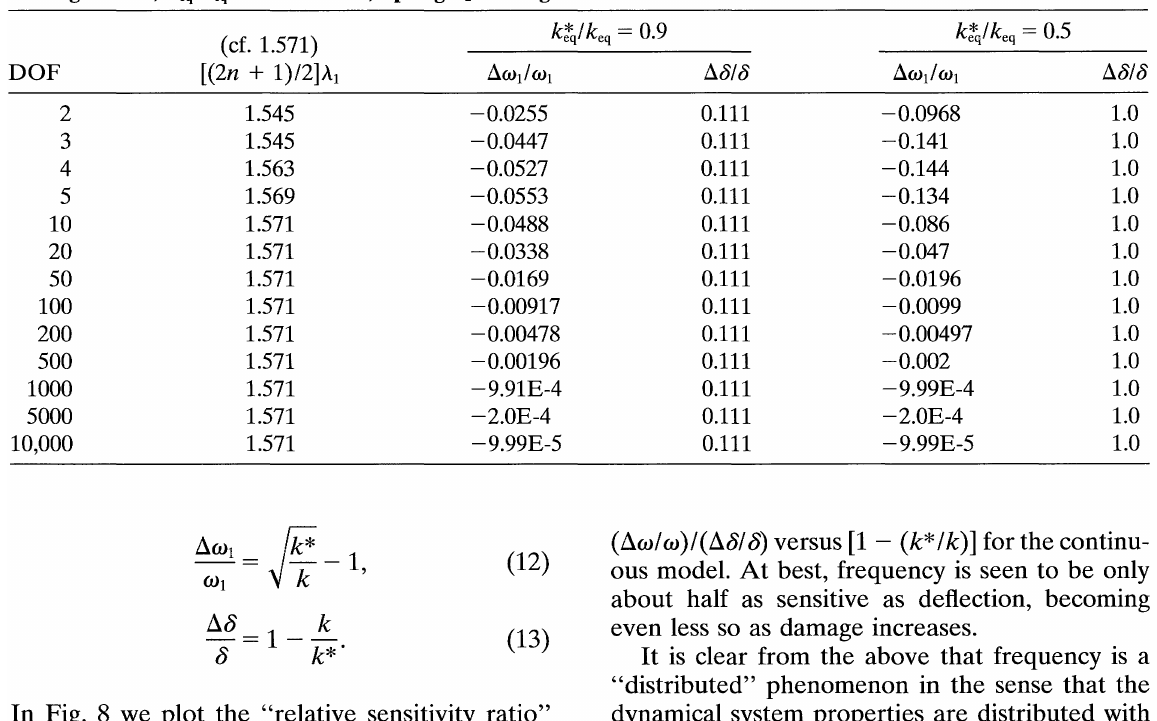
Table 3. Frequency and Deflection Sensitivities for Longitudinal Motion of Fixed-Free Beam for Two Values of Damage Ratio, k'trlk eq = 0.9 and 0.5; Spring k2 Damaged